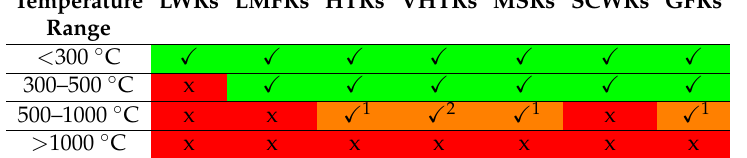
Table 1. Industrial heat demand temperature ranges from the literature and reactor systems, including